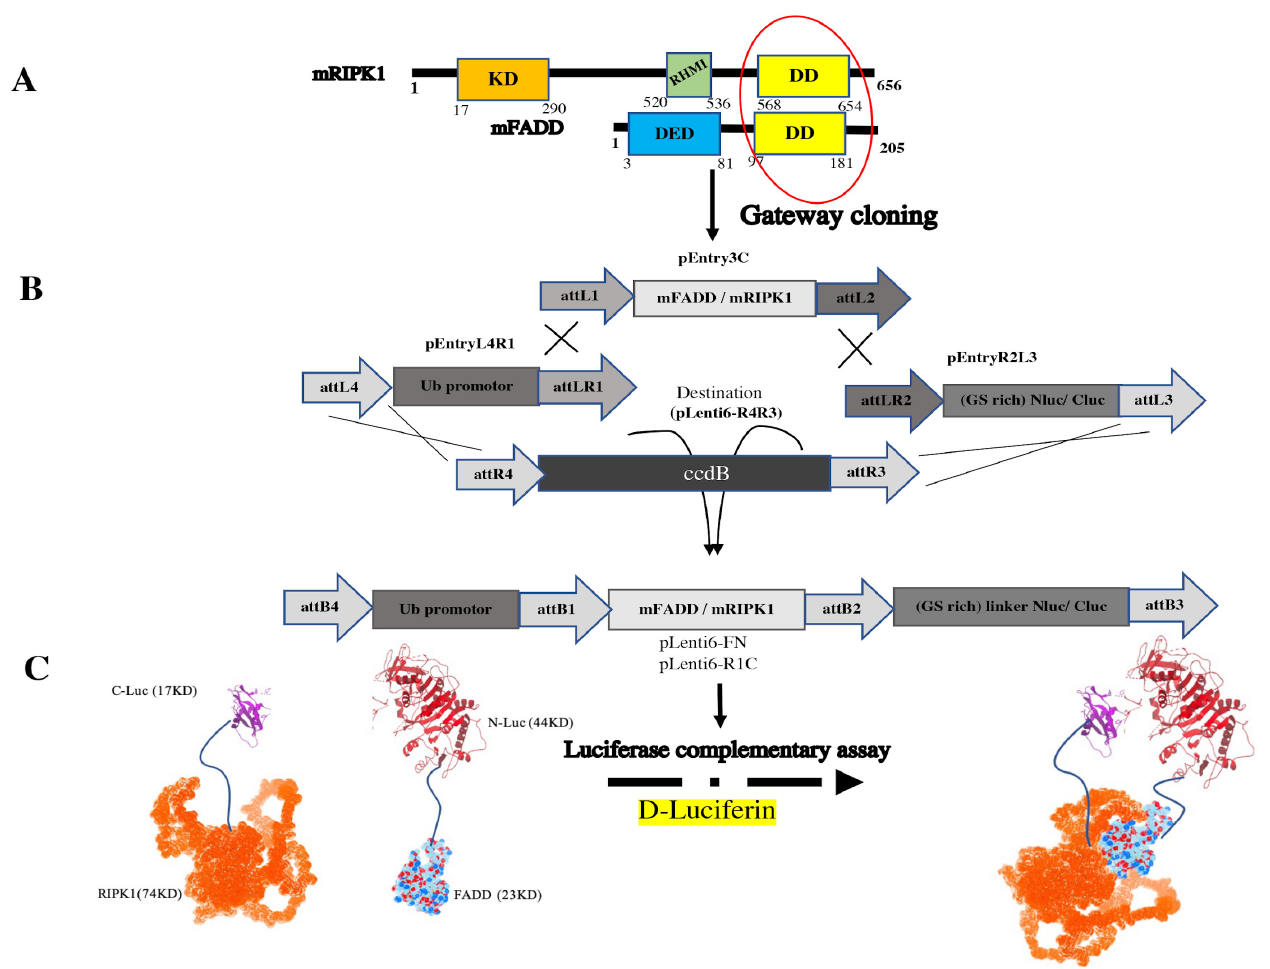
Figure 1. Strategy of generating FN and R1C. ( A ) The sequences of mFADD and mRIPK1 that bind to each other in DD homotypic interaction (marked with a red circle). ( B ) Cloning procedure of constructs was conducted by Gateway cloning. ( C ) Split luciferase enabled sensor for the detection of interaction between mRIPK1 and mFADD fused to CLuc and NLuc, respectively. The structures of RIPK1 (Uniprot: Q60855) and FADD (Uniprot: Q61160) are obtained from the AlphaFold Protein Structure Database (https://alphafold.ebi.ac.uk/, accessed on 20 July